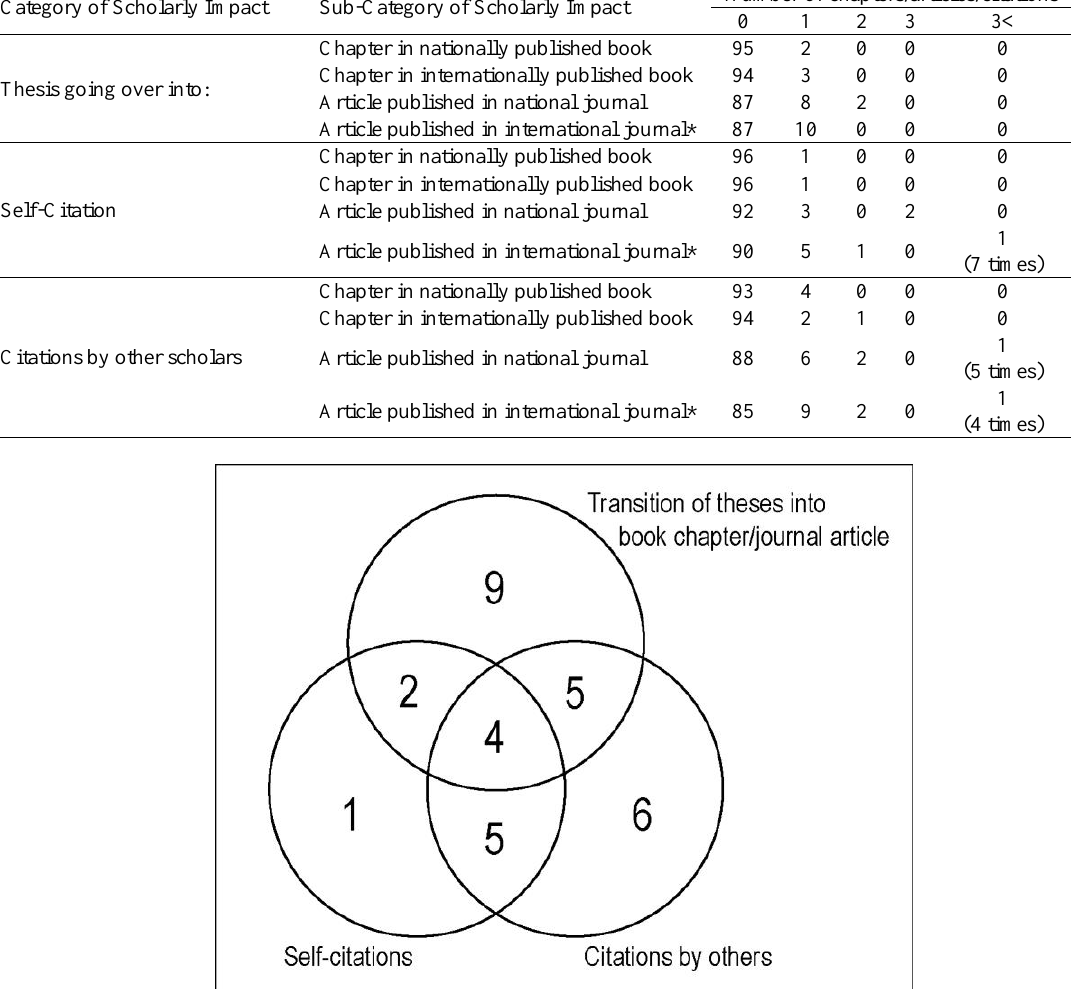
Table 2 The various forms of scholarly impact which theses completed at South African universities in fields of education from 2008-2013 (inclusive). (Figures indicate number of theses)